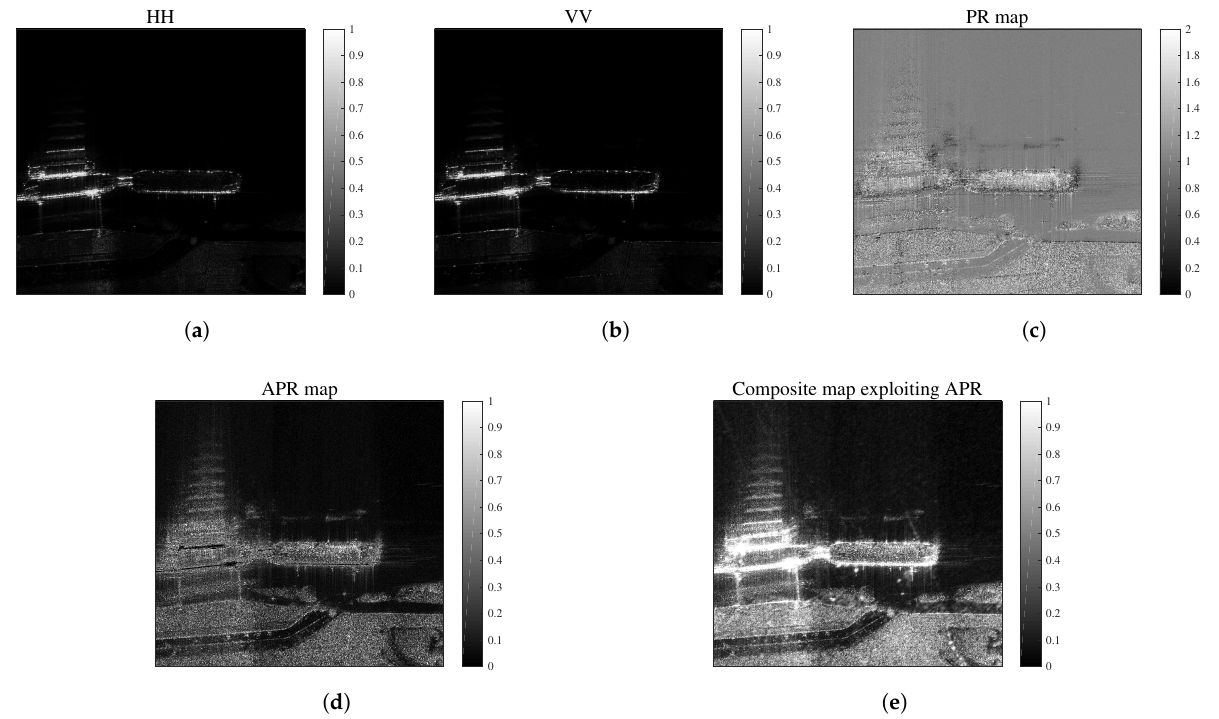
Figure 5. Illustrative example of APR feature exploitation: ( a ) Airborne SAR image with horizontal polarization, denoted as I HH a ; ( b ) Airborne SAR image with vertical polarization, denoted as I VV a ; ( c ) PR map with respect to I HH a and I VV a ; ( d ) APR map with respect to I HH